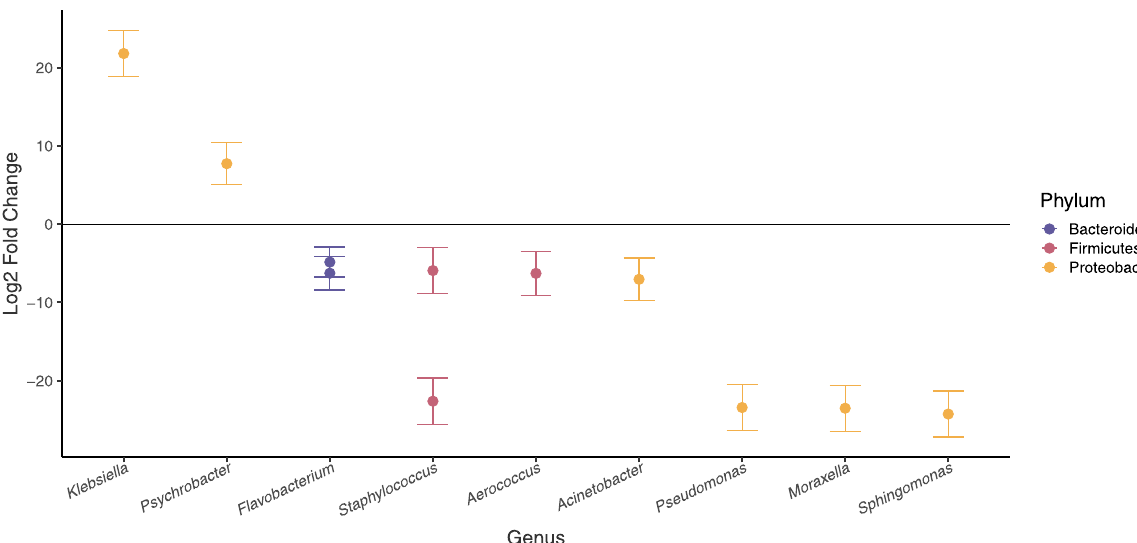
Fig. 4 Log2 fold change (i.e. log-of-the-fold-change) in abundance of potentially pathogenic genera that differed significantly between healthy and diseased individuals. The magnitude and direction of change is displayed as the change in abundance of microbes on diseased individuals when compared to healthy individuals (i.e., genera enriched in diseased animals are positive values and those enriched in healthy individuals are negative values)